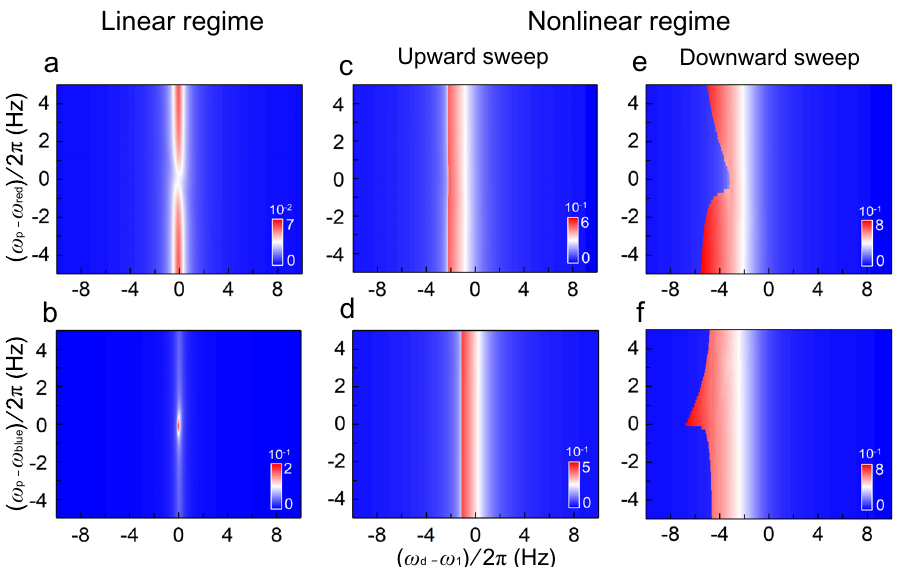
Fig. 3 Numerical solutions to the phonon-cavity system operating in linear and nonlinear regimes. All results are presented in 2D color plots. a , b Calculated response of the ω 1 mode in linear regime with pumping frequency ω p near the ( a ) red sideband ω red and b blue sideband ω blue of the phonon-cavity. c , d Nonlinear response of the ω 1 mode with an upward frequency sweep, with pump frequency ω p near the red sideband ω red ( c ) and blue sideband ω blue ( d ), respectively. e , f Nonlinear response of the ω 1 mode with a downward frequency sweep, with pump frequency ω p near the red sideband ω ω red ( e ) and blue sideband blue ( f ), respectively, showing clear modulation of the bi-stability frequency details are provided in “ Methods ” and SI 2.3 – 2.4, with additional data in SI